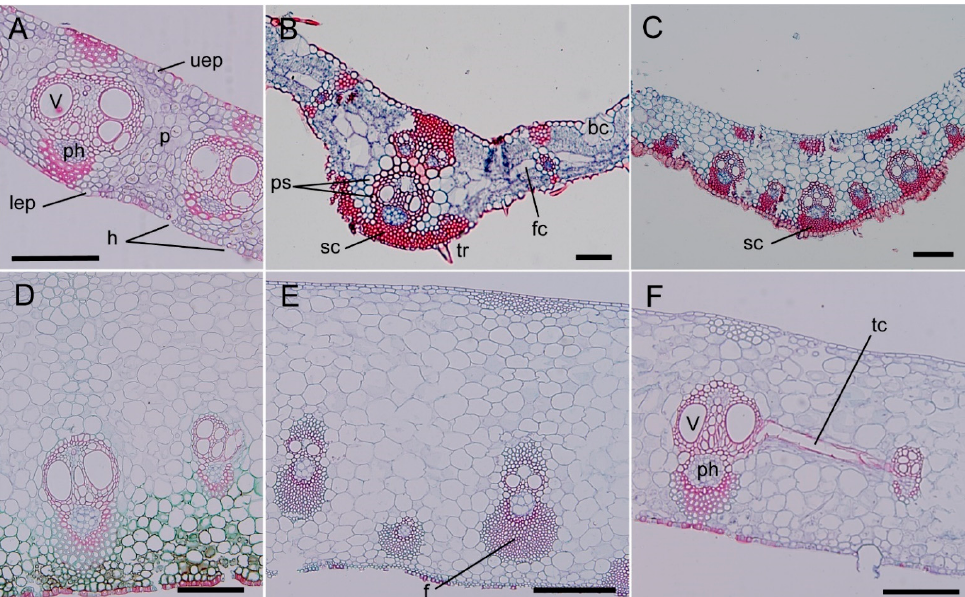
Figure 5. Transverse section of the culm sheath and bamboo leaf. ( A ) The sheath blade of moso bamboo. ( B ) The leaf of moso bamboo. ( C ) The leaf sheath of moso bamboo. ( D , E ) Base and upper part of culm sheath proper. ( F ) Cross-section of culm sheath proper. v, vessel element; ph, phloem; h, hydathode; p, parenchyma; bc, bulliform cells; fc, fusoid cells; sc, sclerenchyma cells; tr, trichomes; ps, parenchymatous sheath cells; uep, upper epidermis; lep, lower epidermis; f, fiber cells; tc transverse catheters. Scale bar = 100 μ m.